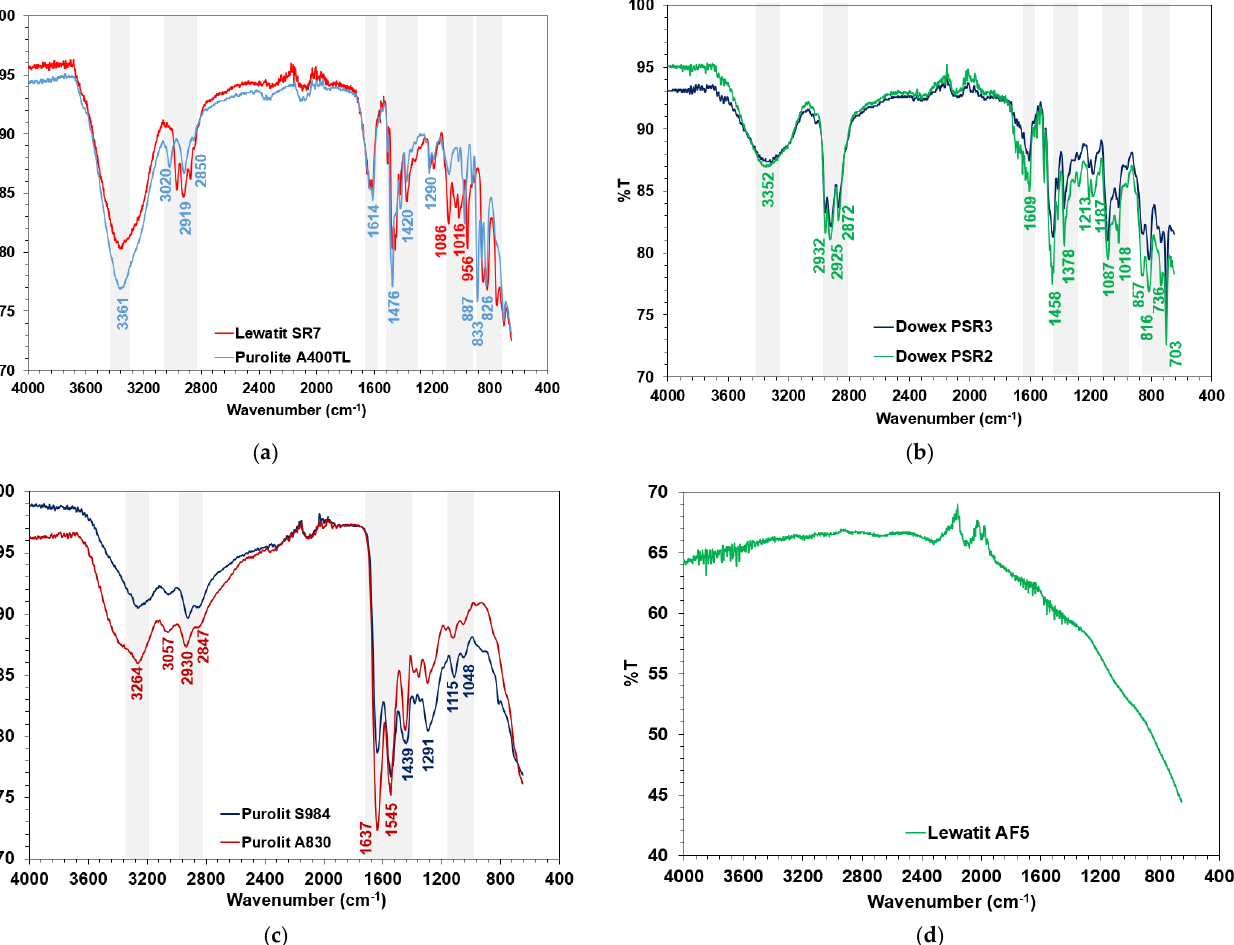
Figure 4. ATR-FTIR spectra: ( a , b ) SBA resins, ( c ) WBA resins, and ( d ) AF5 applied for vanadium (V) removal.